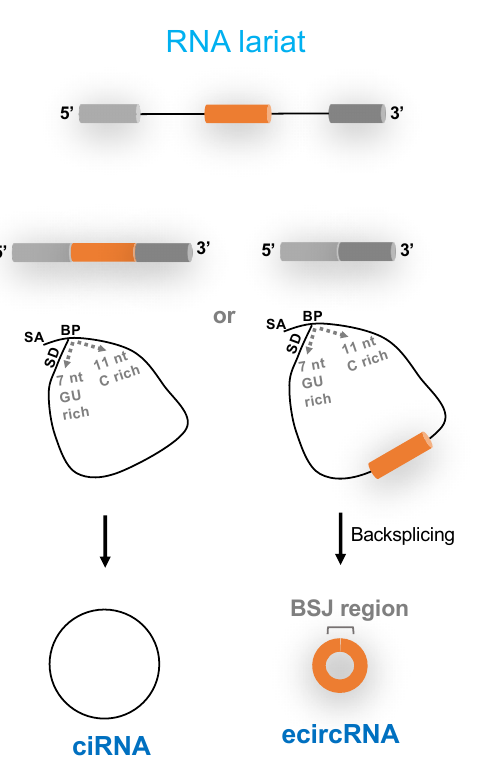
Figure 1. Biogenesis of circular RNAs. Circular RNA generated from RNA lariats or backsplicing. A signature of 7-nt GU rich motif near the 5’ splice site and an 11-nt C-rich motif at the branchpoint site is critical for RNA lariats to escape debranching, thereby generating ciRNAs and ecircRNAs (after another backsplicing step). Backsplicing occurs with the presence of flanking inverted repeat elements (e.g., Alu elements) and/or the aid of RNA-binding proteins (RBP). SA, splicing acceptor. SD, splicing donor. BP, branching point. BSJ, backsplicing joint.